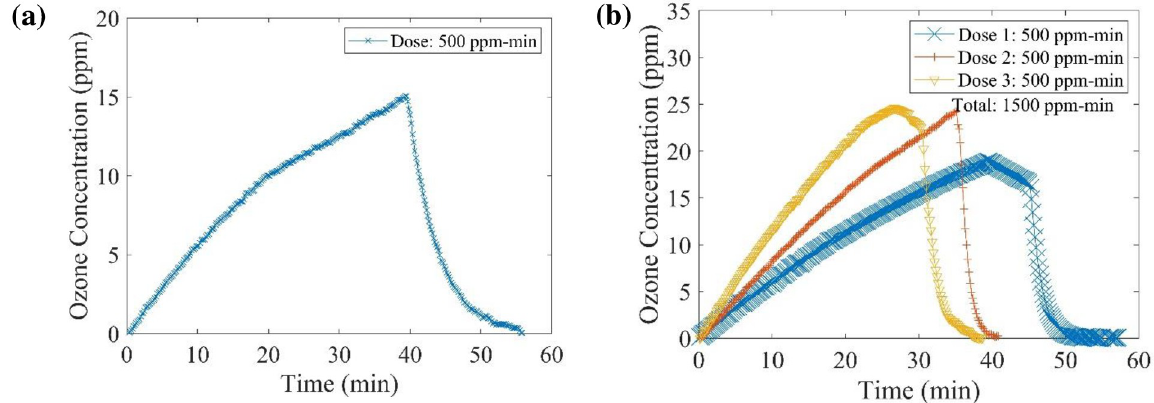
Fig 5. Ozone concentration versus time with delivered doses of (a) 500 ppm-min and (b) 1500 ppm-min during N95 respirators decontamination (Glovebox).